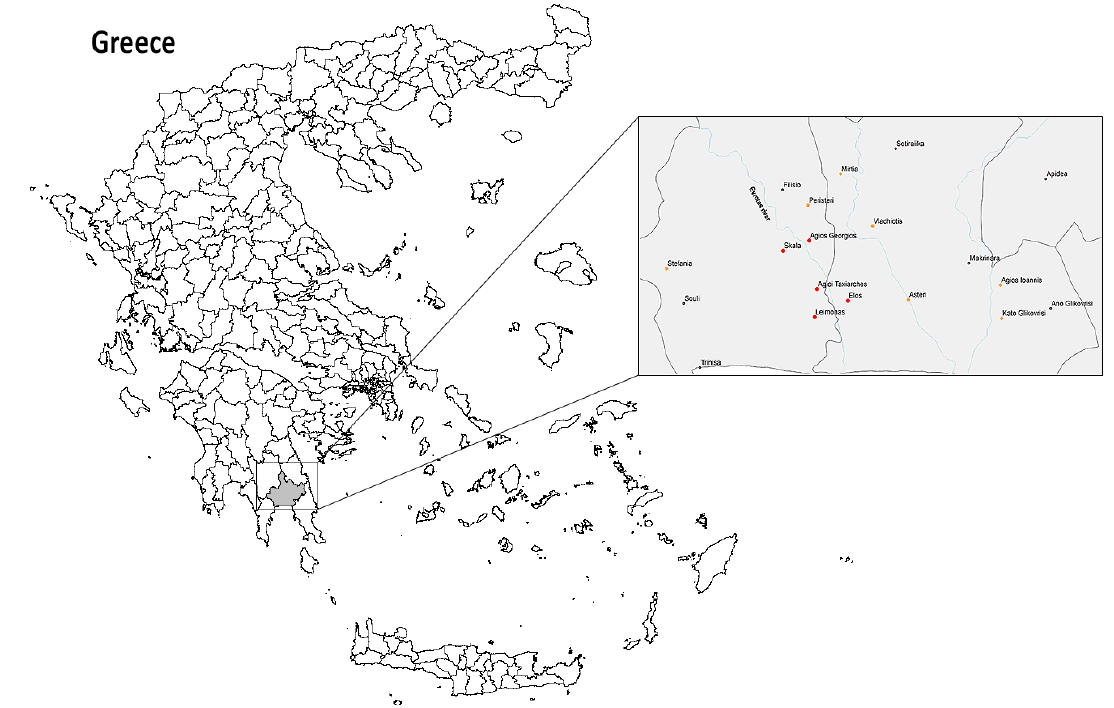
Figure 1. Malaria Pro-Active Case Detection program implementation in 12 villages of Evrotas Municipality (gray colored on the map of Greece): five villages at the epicenter of the 2011 outbreak (red colored bullets) and seven surrounding villages (orange colored bullets).